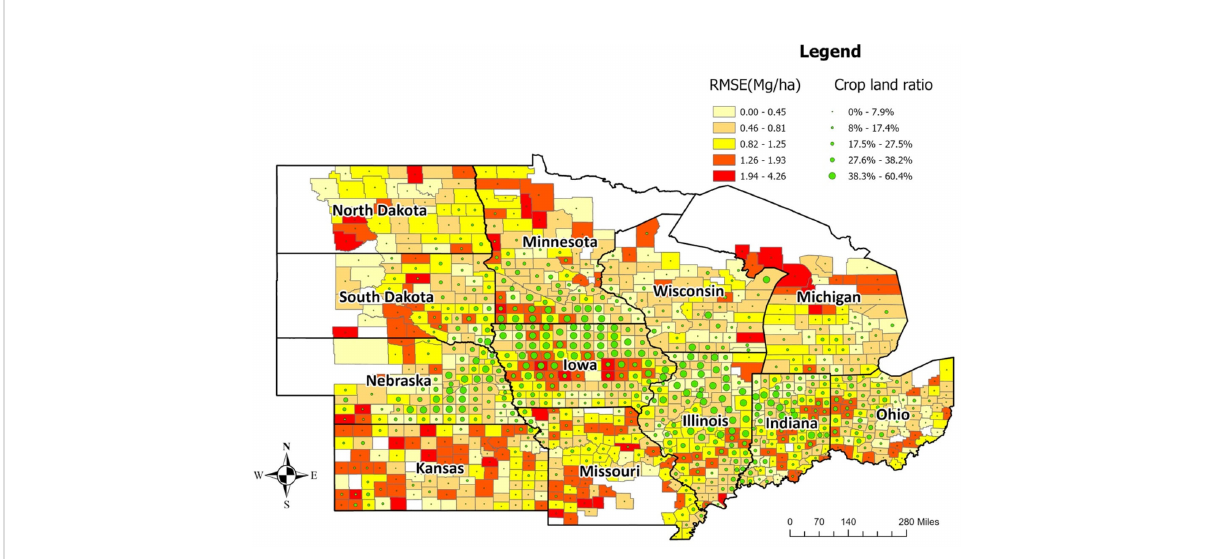
FIGURE 6 Average model performance at the county level in terms of RMSE (the year 2018-2020). The lighter color corresponds to lower RMSE (ranging from 0 to 1.25Mg/Ha), whereas the darker color stands for higher RMSE (ranging from 1.26 to 4.26Mg/Ha). The green circles provide information on the cropland ratio of the county. Iowa, Illinois, Indiana, Ohio, and Nebraska have lower prediction